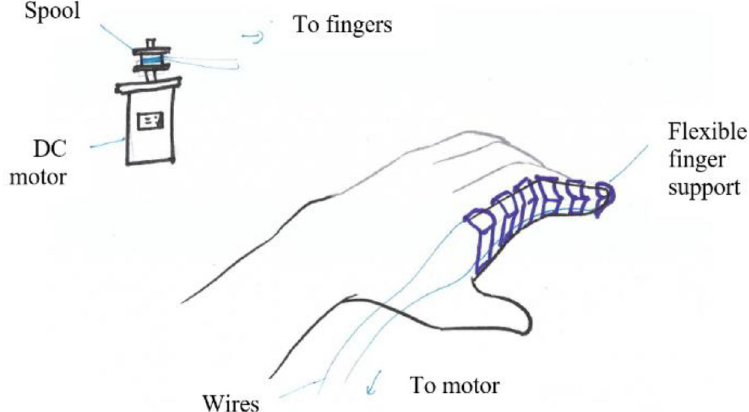
Figure 17. Concept 2 – Wires for flexible finger